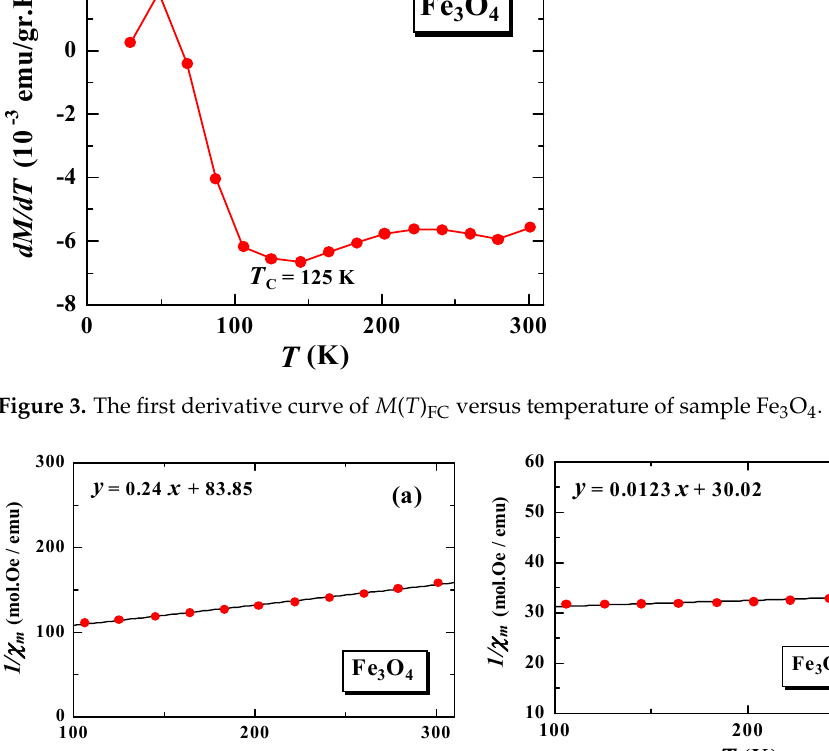
Figure 4. The fitting of Curie–Weiss law on M FC data of Fe 3 O 4 ( a ) and Fe 3 O 4 -SiO 2 ( b ). By using the C value from the fitting and Equation (2), the effective magnetic moment value is obtained. These magnetic quantities are shown in Table 1. For reference, we also displayed the H C values for the Fe 3 O 4 and Fe 3 O 4 -SiO 2 samples [16]. Table 1. The magnetic quantities of Fe 3 O 4 and Fe 3 O 4 -SiO 2